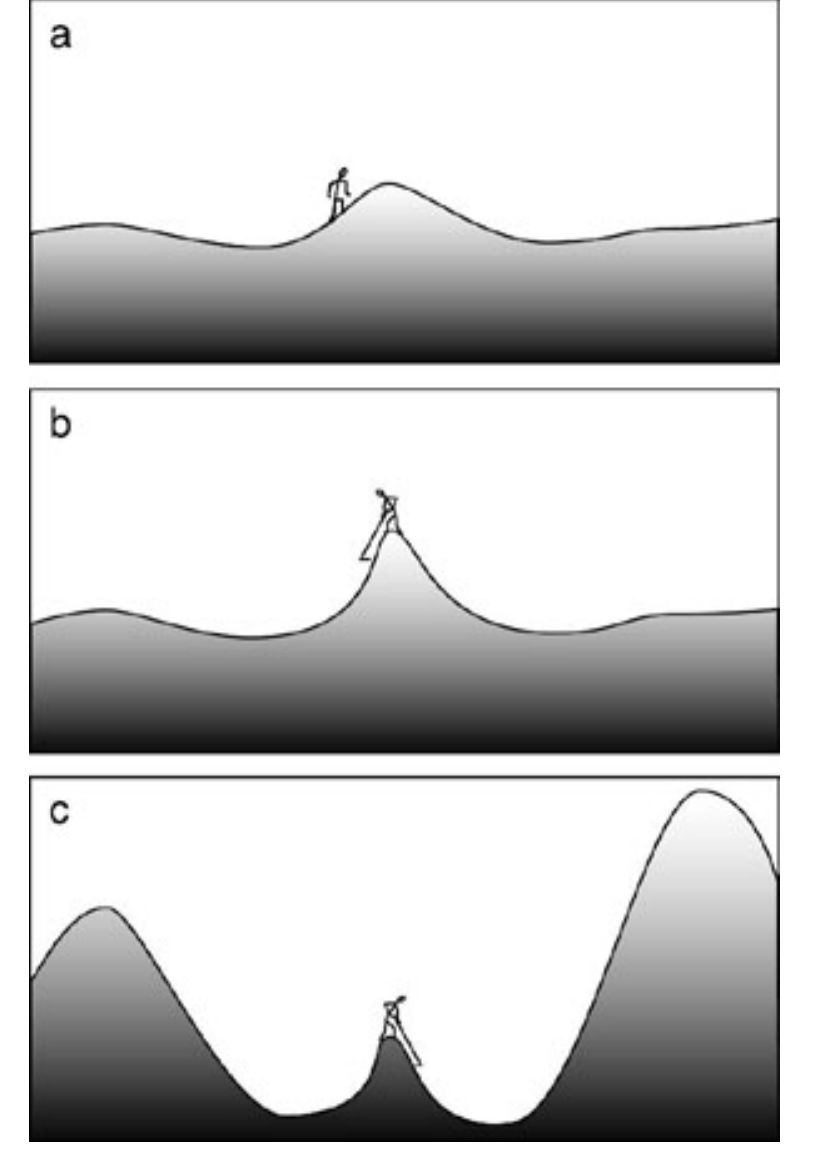
Fig. 5. Cartoon of the efficiency trap. If exploration has revealed an optimum in the fitness landscape (panel a), a person, group, or company may shift to an exploitative mode where improved efficiency and specialization enhances the fitness further (panel b). However, in such a behavioral mode, the explorative capacity to scan for alternative options is reduced. This implies the risk of becoming trapped in a situation that may seem optimal from a myopic view, but is suboptimal compared with potentially much better places in the changing fitness landscape (panel